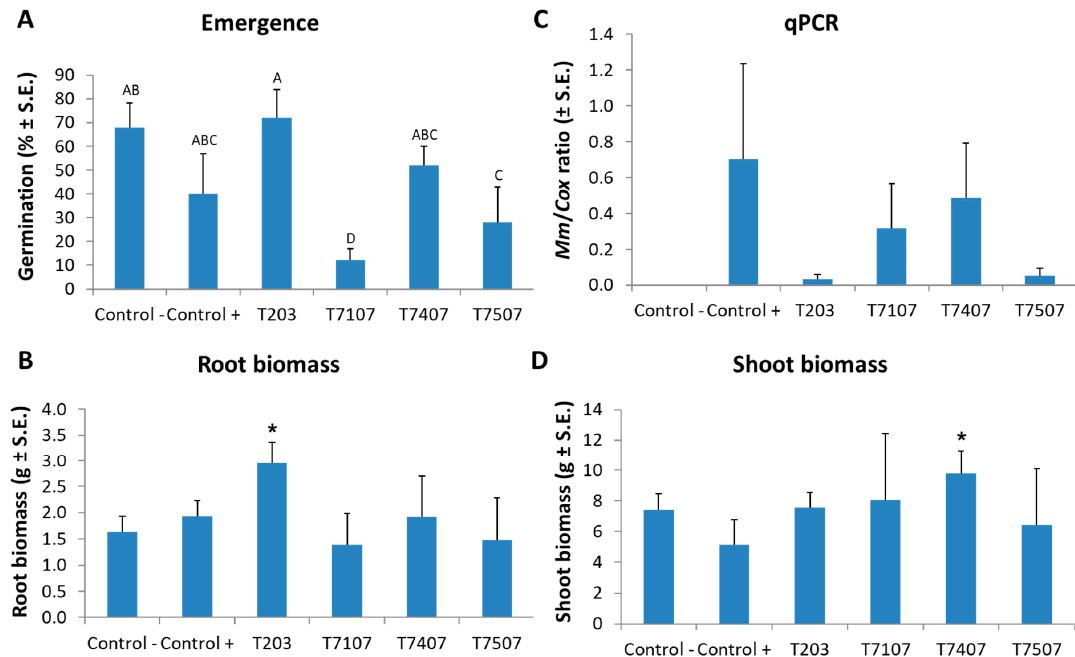
Figure 6. Maize sprout average growth indices at 40 DAS due to infection with M. maydis and Trichoderma spp. addition. The Trichoderma species tested are listed in Table 1. The emergence above the ground surface ( A ) was evaluated after 6 days. All other measures, roots’ wet biomass ( B ) and qPCR results ( C ), and stalk wet biomass ( D ), were determined at the experiment end. The real-time PCR (qPCR) results ( C ) are a relative amount of M. maydis DNA extracted from root samples normalized to the cytochrome C oxidase (COX) DNA. Control -, is soil without M. maydis infection. Control +, is the same soil with infection. All Trichoderma spp. treatments were conducted in such infected soil. The experiment was performed for 5 repetitions. Error lines represent a standard error. In ( A) , a statistically significant (one-way ANOVA, p < 0.05) difference between the treatments was indicated by different letters (A–D). No statistical difference was identified using the one-way ANOVA test in (B, C, D). However, a one-tailed t -test compared to the infected control (which is a more powerful test) revealed significant differences ( p < 0.05), indicated by an asterisk (*).